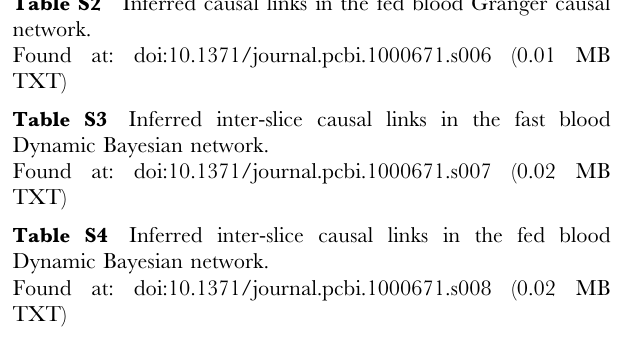
Table S2 Inferred causal links in the fed blood Granger causal network. Table S3 Inferred inter-slice causal links in the fast blood Dynamic Bayesian network. Table S4 Inferred inter-slice causal links in the fed blood Dynamic Bayesian